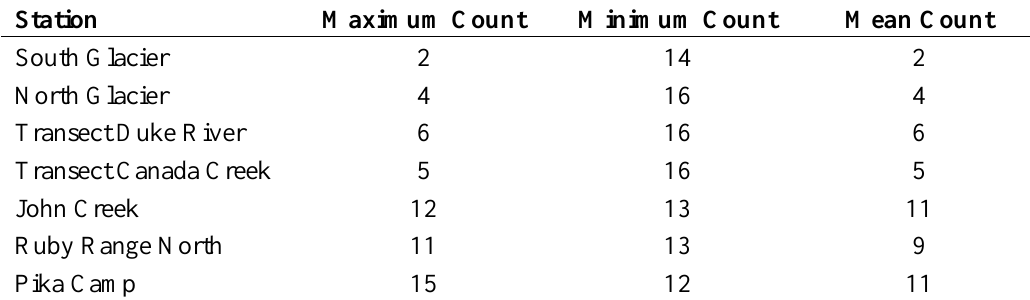
Table 4. Number of 8-day composite values observed and calculated (mean) for seven meteorology stations for period between 1 May and 31 August